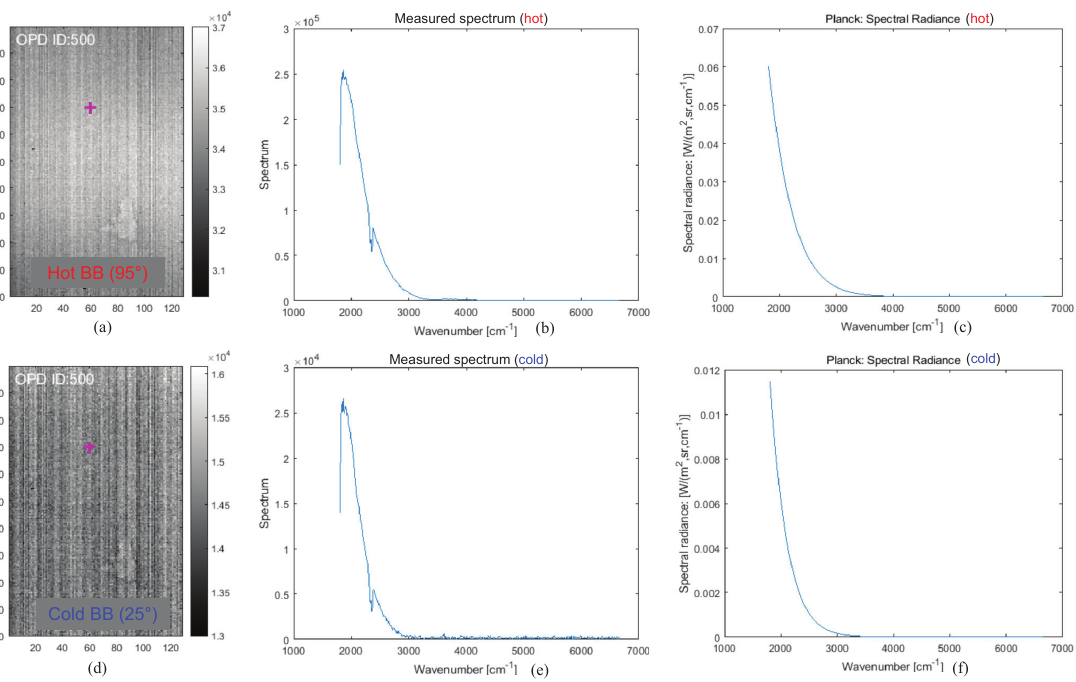
Figure 4. Blackbody spectrum and spectral radiance extraction for a radiometric calibration: ( a ) interferogram image of a hot blackbody (95 ◦ C); ( b ) measured spectrum of a hot blackbody; ( c ) calculated spectral radiance at hot temperature; ( d ) interferogram image of a cold blackbody (25 ◦ C); ( e ) mesured spectrum of a cold blackbody; ( f ) calculated spectral radiance at cold